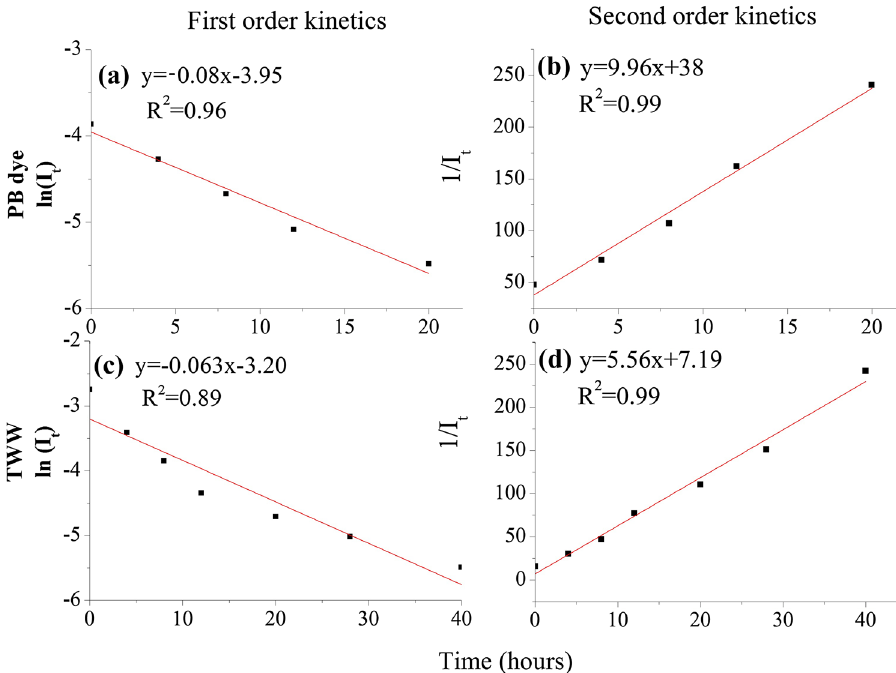
Fig. 6 First-order ( a , c ) and second-order ( b , d ) kinetics of the degradation DOM of PB dye and TWW with Fe 2 O 3 NPs under visible light